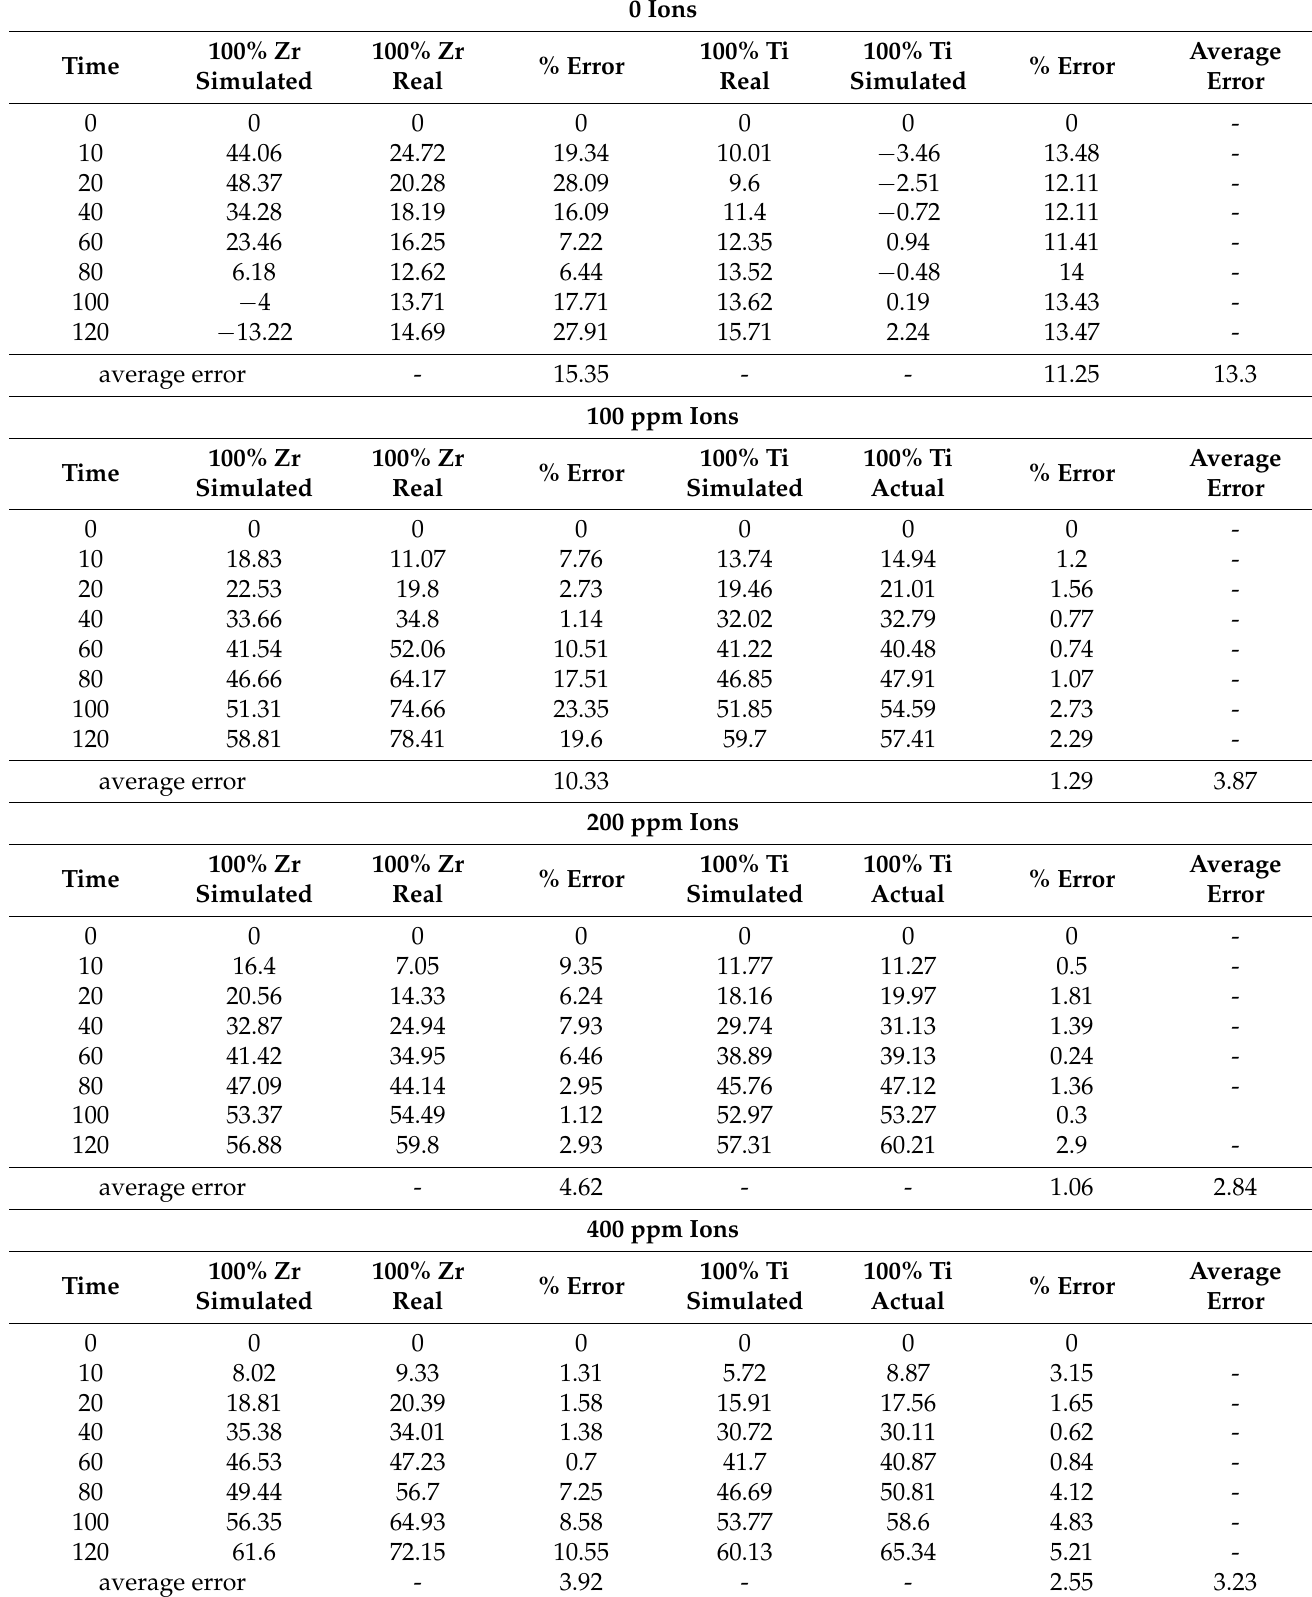
Table 7. Evaluation of Equation (1) in the prediction of 100% Ti and 100% Zr samples. 0